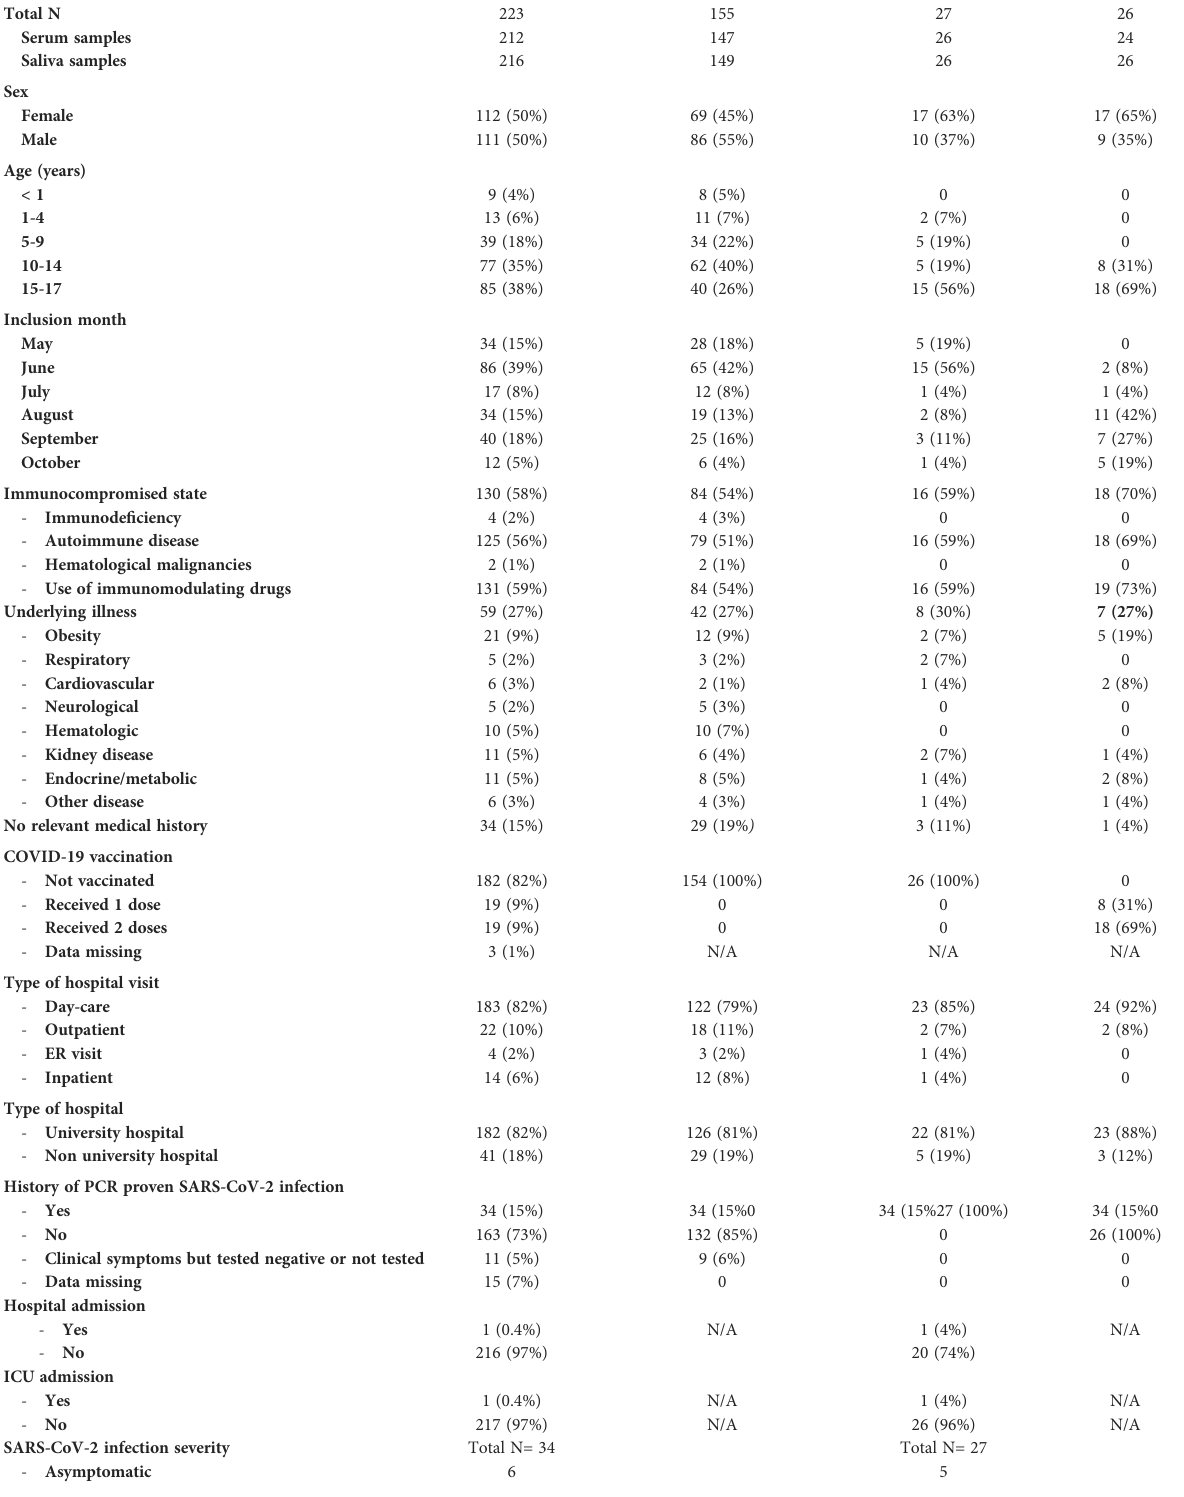
TABLE 1 Study population